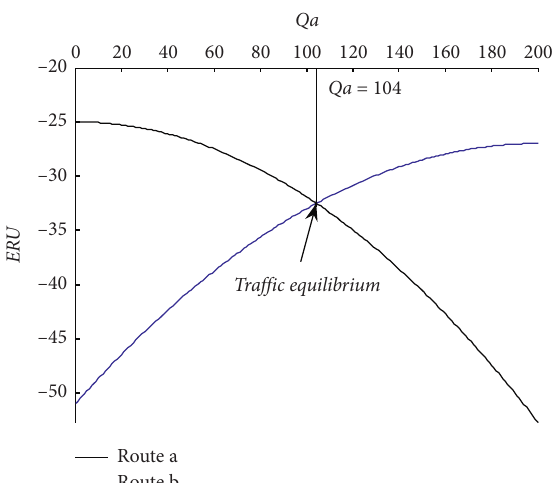
Figure 8: Expected regret-based utility without risk and regret aversion. Note. the black line denotes route a , and the blue line denotes route b ; Q b � 200 − Q a Table 2: Influence of risk aversion and regret aversion on traffic equilibrium.